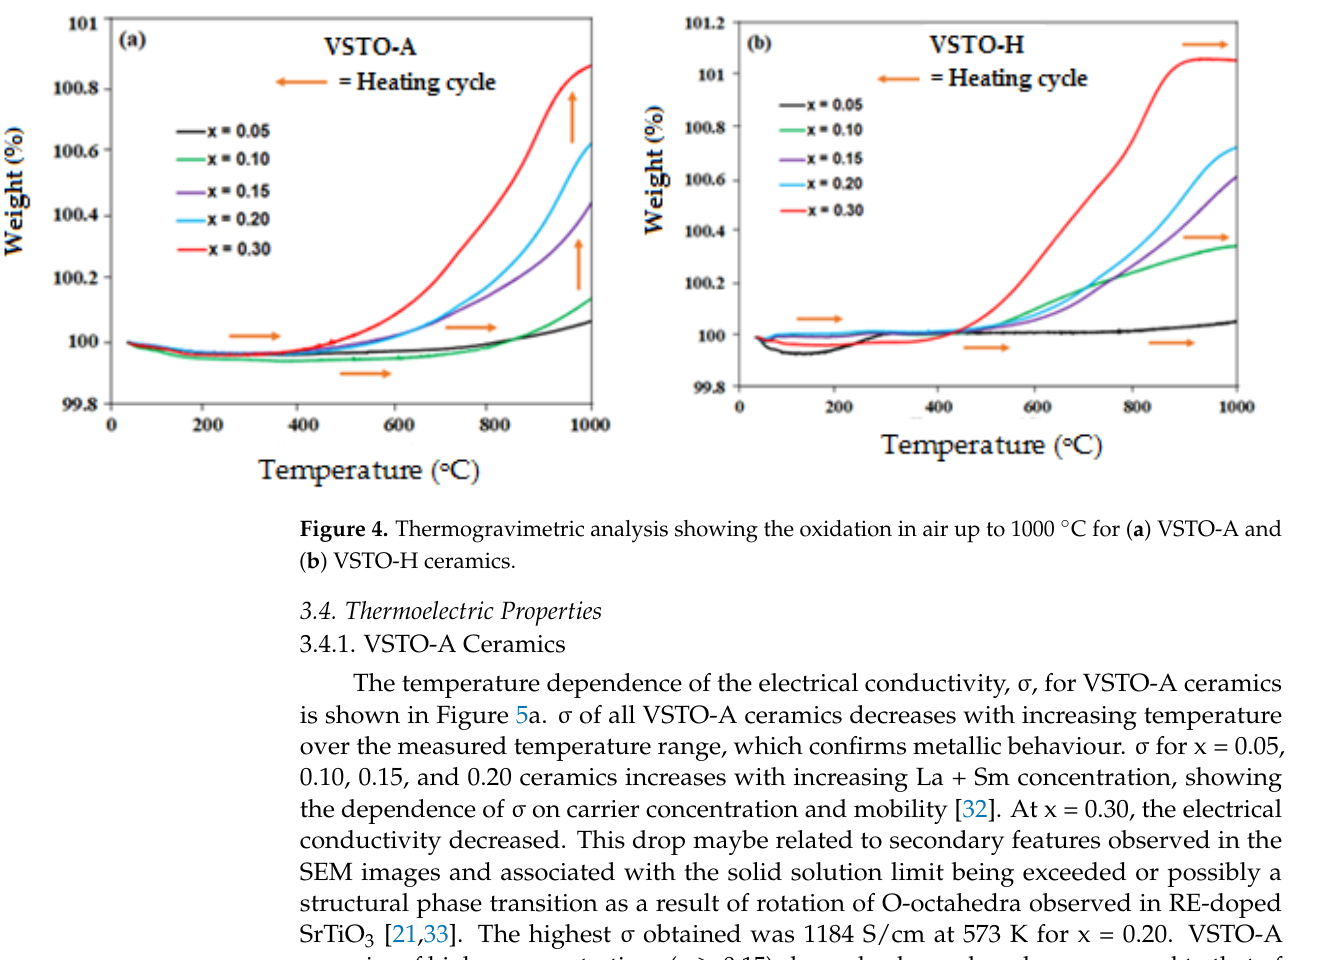
oxidation in air up to 1000 °C. The colour of VSTO-A ceramics after TGA remained black